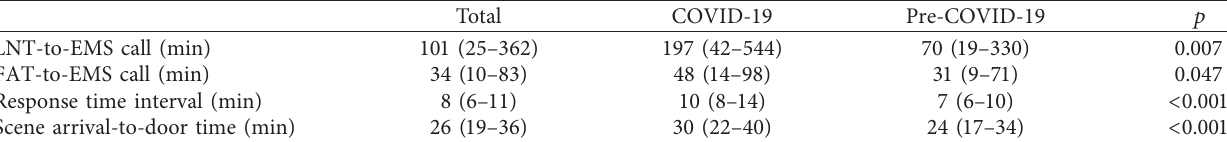
Table 3: Prehospital transport times for public emergency medical services.